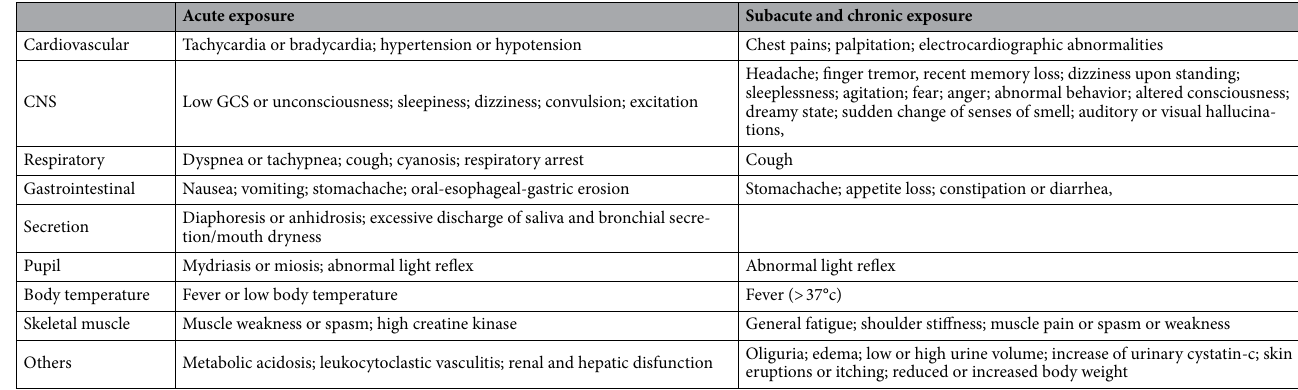
Table 3. Typical symptoms of neonicotinoid